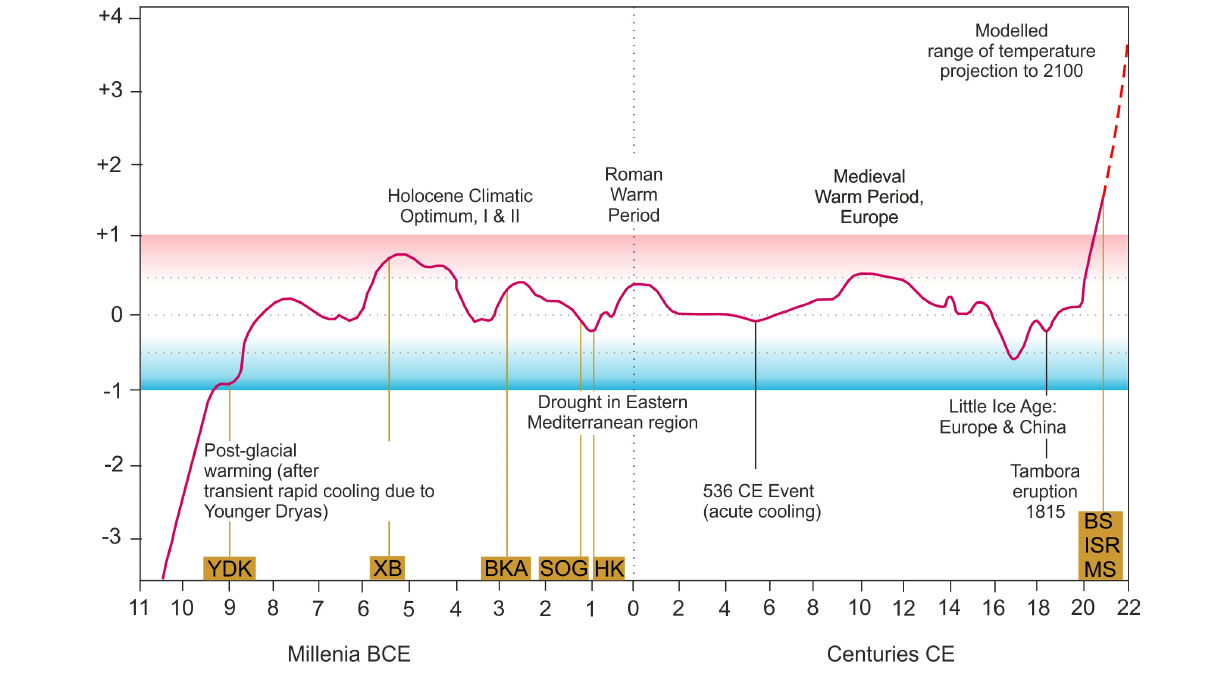
Frontiers in Ecology and Evolution |